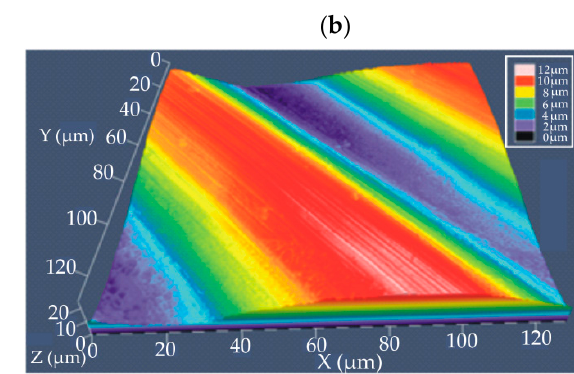
Figure 3. EDS analysis for casein coatings applied to ( a ) MgCa2Zn1 and ( b ) MgCa2Zn1Gd3 alloys.